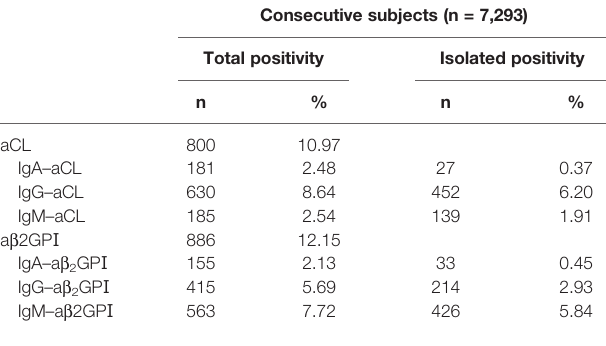
TABLE 3 | Pro fi le features of antiphospholipid antibodies in a large-scale cohort.